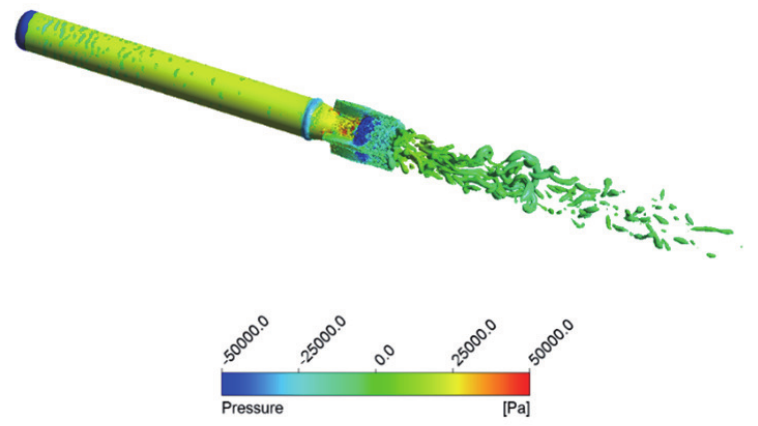
Figure 4. Vortex